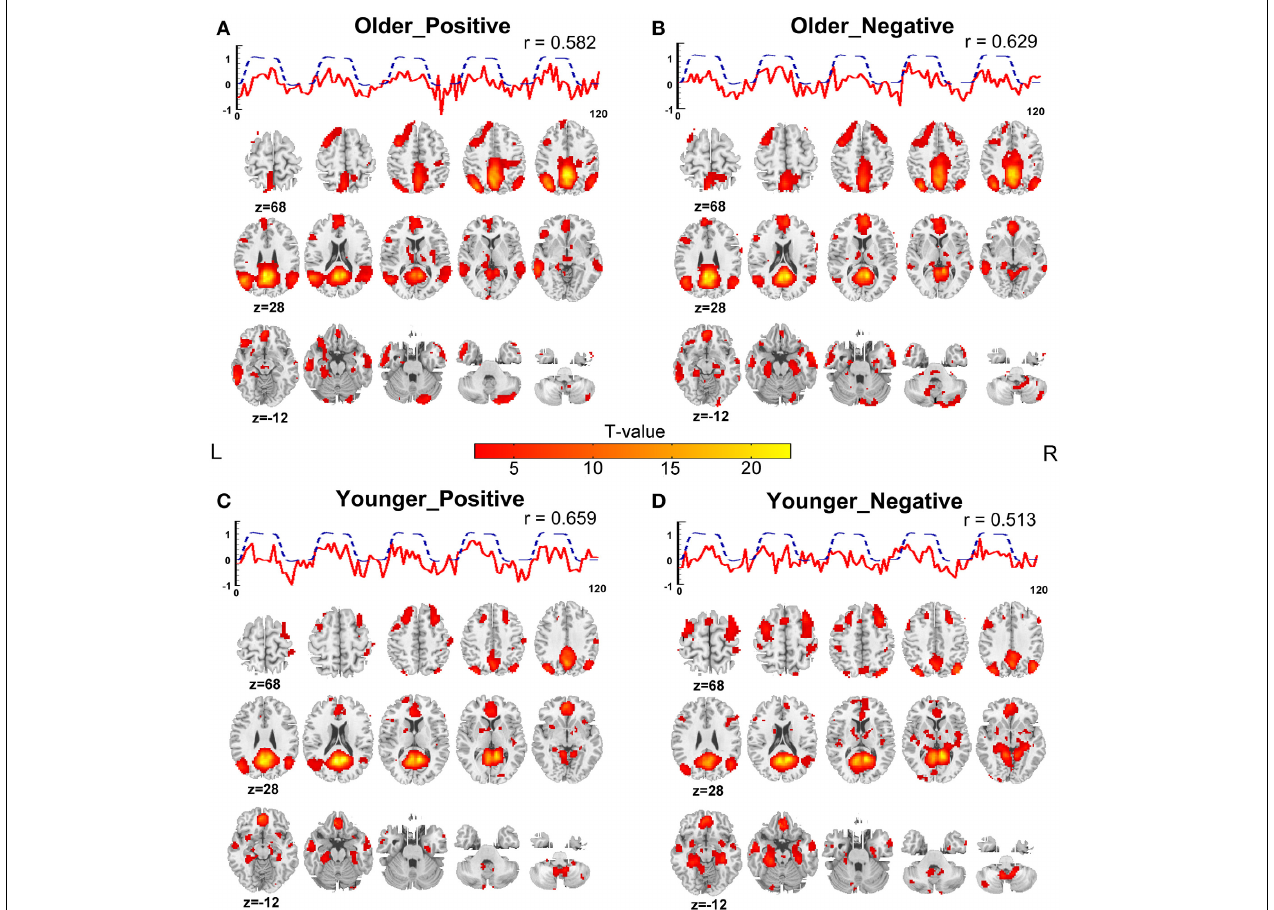
FIGURE 4 | Spatial activation maps of the task-related components and associated time courses. (A) Positive memory retrieval of the older adults. (B) Negative memory retrieval of the older adults. (C) Positive memory retrieval of the younger adults. (D) Negative memory retrieval of the younger adults. The statistical threshold was set at p < 0 . 05, corrected for multiple